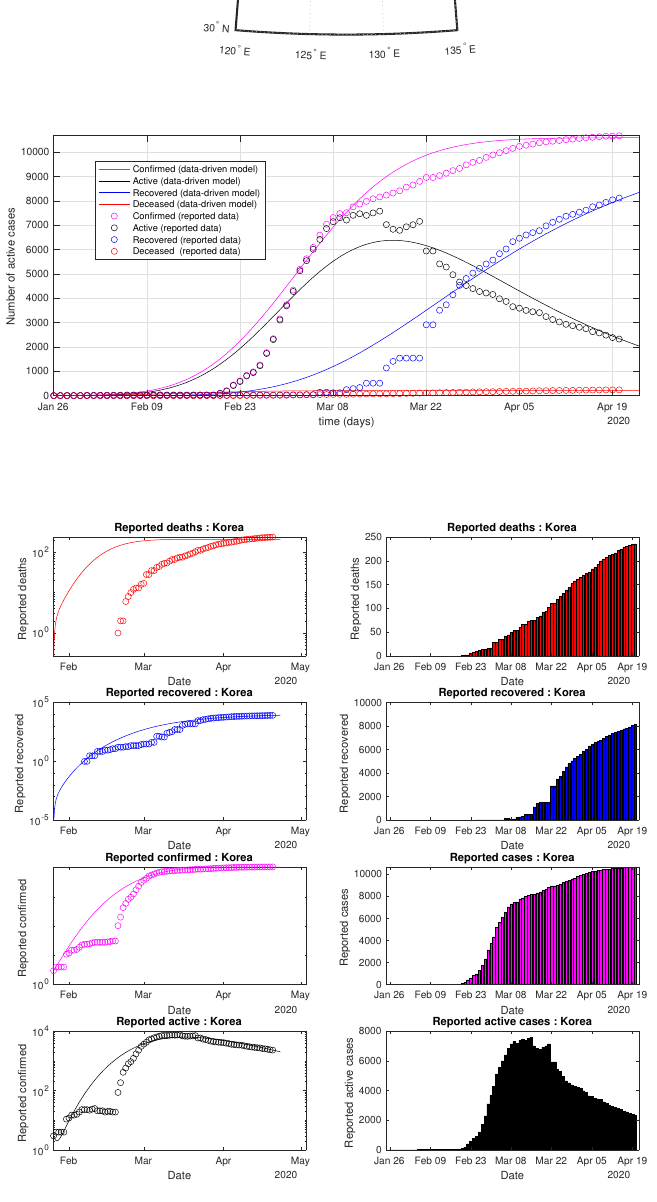
Figure 37. South Korea: data of active, recovered, deceased (in circle or bar) vs. model of active, recovered, deceased over time. Tracking the number of active cases. Predictive analytics for the next couple